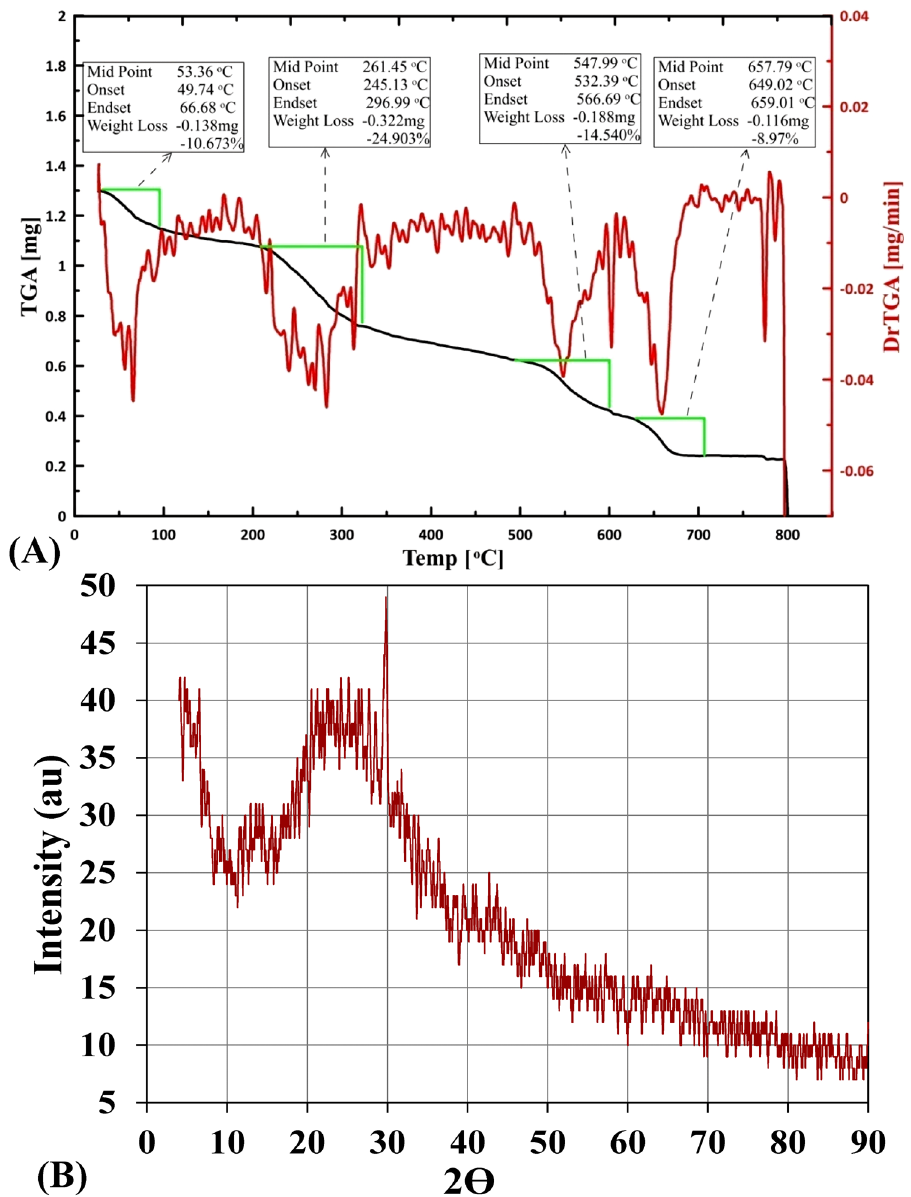
Figure 2. ( A ) Thermogravimetric analysis (TGA), ( B ) X-ray diffraction of extracted sodium